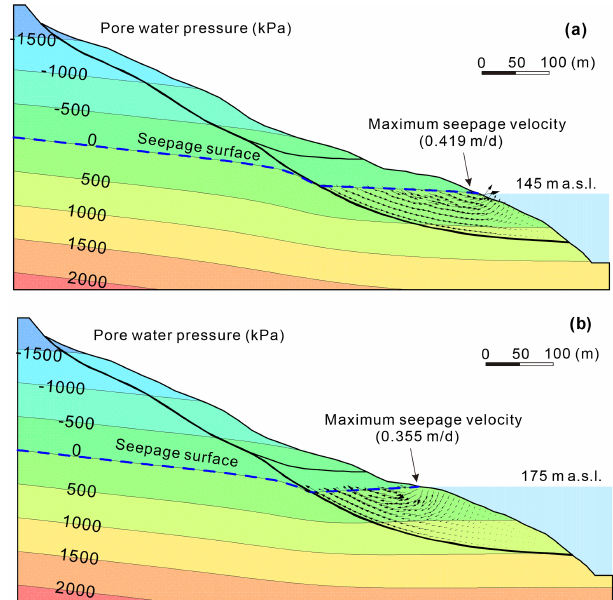
Figure 17. (a) Simulated pressure contours and flow vector at the end of the rapid-drawdown period (day 165 in Fig. 16), (b) simu- lated pressure contours and flow vector at the begin of the high-level period (day 303 in Fig.